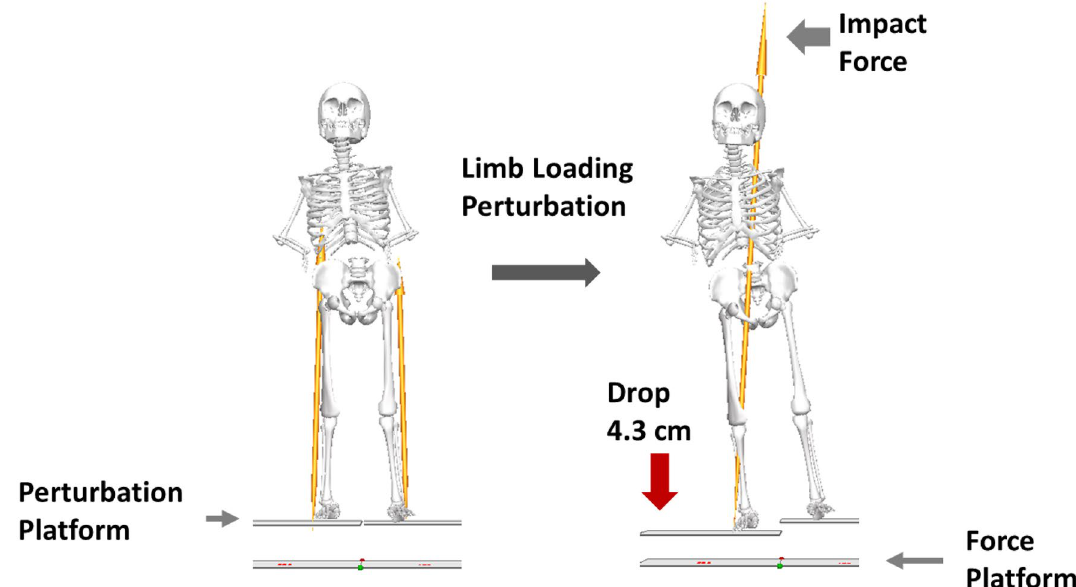
Figure 1. Schematic diagram of the imposed limb loading perturbation. The figure is generated using Visual3D (C-motion, inc., MD, US) and Microsoft PowerPoint (Microsoft, WA, (VL), biceps femoris (BF), medial gastrocnemius (MG), and tibialis anterior (TA) muscles. EMG signals were sampled at 1500 Hz for 7 s. Data analyses. Overground walking speed, double support duration (% gait cycle) when the paretic limb was the leading limb, and double support duration (% gait cycle) when the non-paretic limb was the leading limb were calculated by the GAITRite software during both self-selected and maximum speed conditions. Kinematic and kinetic data were low pass filtered at a cutoff frequency of 6 and 30 Hz, respectively. EMG signals were bandpass-filtered at 16–500 Hz, de-meaned, full-wave rectified, and lowpass-filtered at 20 Hz. All the data were processed offline with a fourth-order Butterworth filter. A custom 15 segment model (head, trunk, pelvis, and bilateral foot, shank, thigh, upper arm, forearm and hand) was used to calculate body center of mass (CoM) position, sagittal plane ankle and knee joint angle, torque and power using Visual3D software (C-motion, inc., MD, US). Downward kinetic energy of the CoM and ankle and knee joint angular velocity were then calculated. The ground reaction forces, joint torque and power, and kinetic energy were all normalized to body mass. Because we were interested in the interval when the downward kinetic energy was absorbed, the impact absorption phase was defined as the time period from the first maximum downward kinetic energy of CoM to the first minimum downward kinetic energy of CoM following a perturbation 36 (Fig. 2). Peak values of the joint angular velocity and torque, and the minimum val- ues of the joint power (i.e. maximum negative power) were extracted from the impact absorption phase. Since the negative value of joint power represents absorption of the energy, absolute values of minimum joint power were defined as peak rate of energy absorption. All calculations were performed with a customized program in MATLAB (The MathWorks, Inc., MA, US). Maximum EMG amplitude within 1 s after perturbation onset was identified for each muscle. The maximum value observed across all four trials was used for normalization 37 . Muscle co-contraction was calculated using Eq. (1) 38 . This method has been shown to better reflect joint stiffness among other commonly used measure- ments of muscle co-contraction 39 .